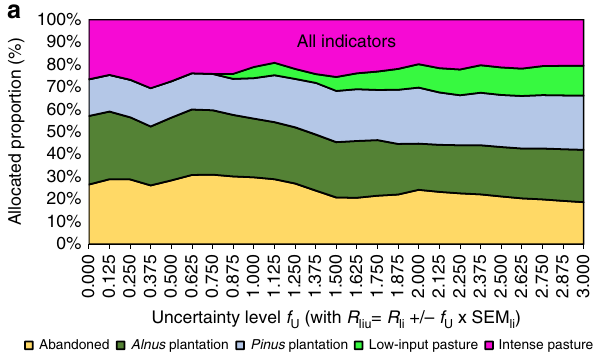
Figure 6 | Dissimilarity of landscape portfolios. The Bray–Curtis index expresses the dissimilarity of the optimized landscape portfolios to a theoretically maximally diversified landscape (that is, coverage of 20% for each land-cover type, with a maximum Shannon index of land-cover diversity of 1.61). Minimum dissimilarity is 0%, maximum dissimilarity is 100%. Dotted lines refer to 95% confidence limits for single dissimilarity values. Subscripts for indicator value, R , l for land-use option, i for indicator, and u for uncertainty deviation from recorded indicator. s.e.m. li of R for land- use option, l , and indicator, i